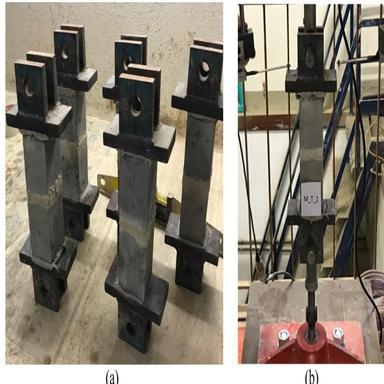
Specimens used to characterize the bond behavior between mortar and stones through direct tensile tests: (a) specimens tested; (b) direct tensile tests performed; (c) crack pattern at failure: (d) detail of the detachment interface.